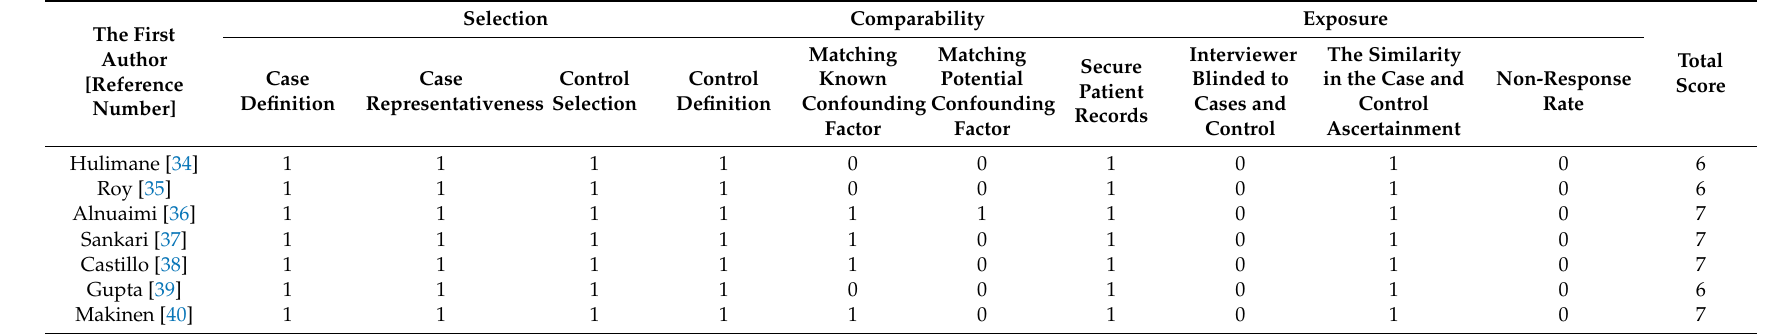
Table 2. Quality of the studies included in the systematic review as assessed by the Newcastle–Ottawa